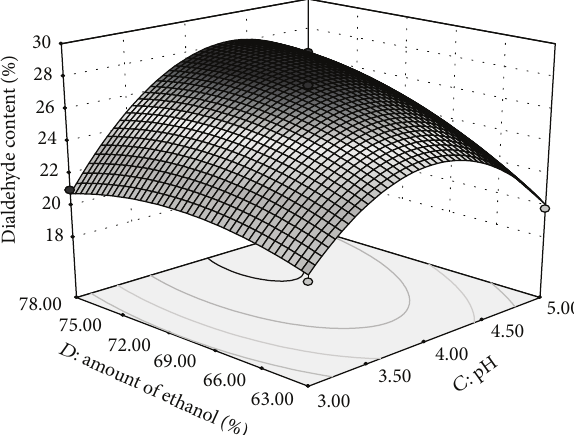
Figure 2: Mutual effect of amount of ethanol and reaction time at fixed pH of 4 and reaction temperature of 40 ∘ C.